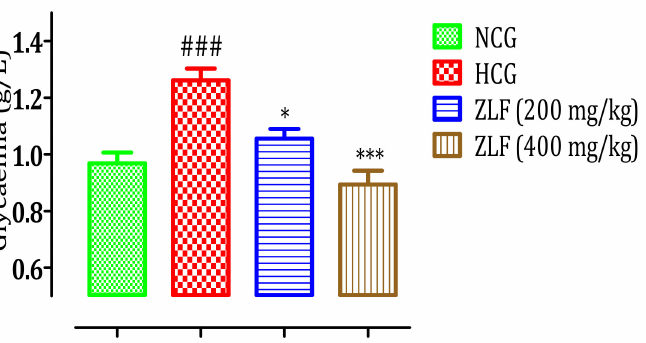
Figure 6. Effect of the aqueous ZLF extract on blood glucose level in mice exposed to HFD. Data are mean ± SEM, n = 6. ### p ≤ 0.001 versus NCG. * p < 0.05, *** p < 0.001 versus HFD